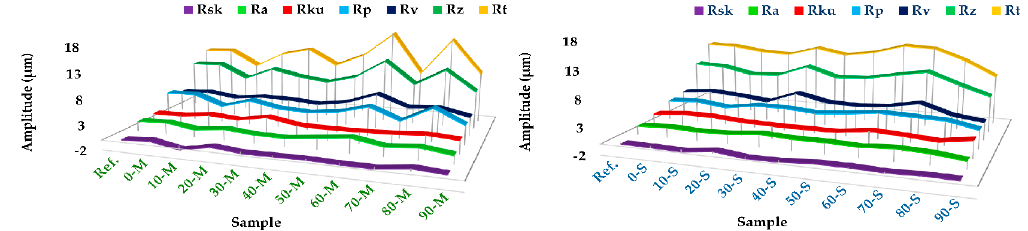
Figure 5. Roughness parameters quantification for marble (M) and seashell (S) derived samples: R sk —profile skewness, R a —profile arithmetic mean deviation, R ku —profile kurtosis, R p —maximum profile peak height, R v —maximum profile valley depth, R z —maximum height of profile, R t —total